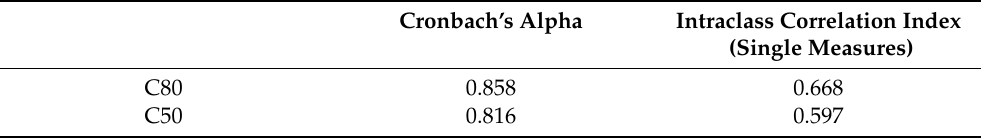
Table 7. Reliability statistics and interclass correlation for C80 and